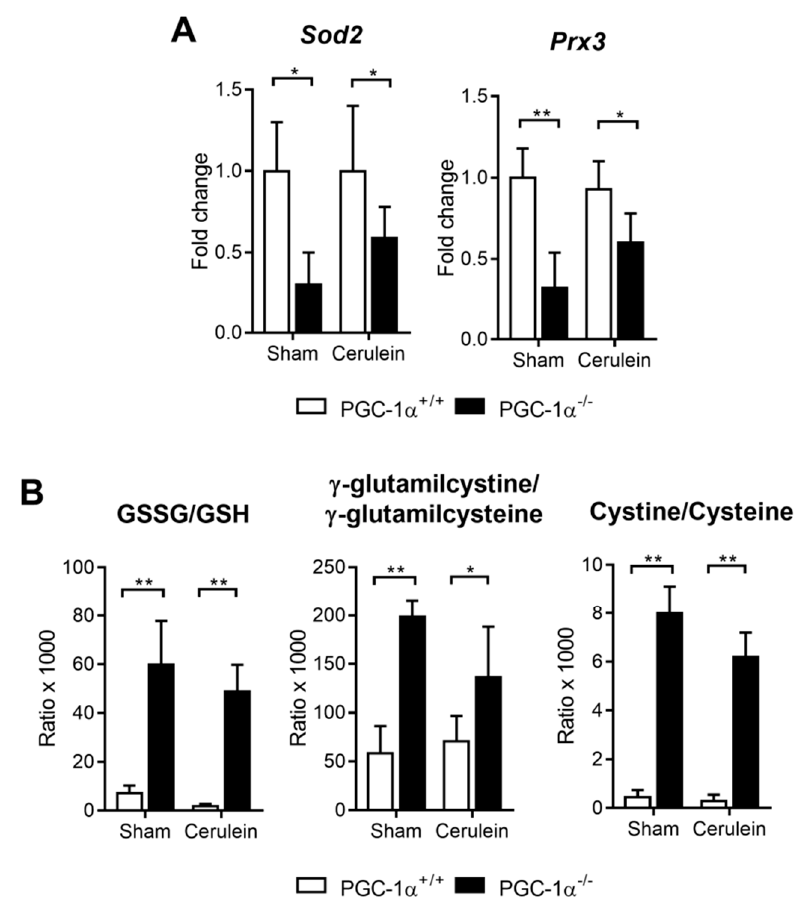
Figure 4. ( A ) mRNA relative expression of Sod2 and Prx3 versus the Tbp (TATA-binding protein; housekeeping) in the livers of the sham PGC-1 α +/+ (WT) and PGC-1 α - / - (KO) mice and at 1 h after cerulein-induced AP (Cerulein). ( B ) The GSSG / GSH, g-glutamilcystine / g-glutamilcysteine and cystine / cysteine ratios in the livers of the sham PGC-1 α +/+ (WT) and PGC-1 α - / - (KO) mice and at 1 h after cerulein-induced AP (Cerulein). There were six mice per group. The statistical difference is indicated as * p < 0.05 and ** p < 0.001.